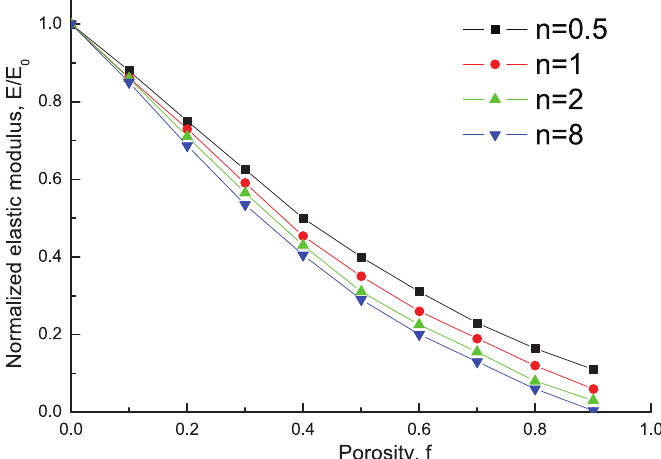
Figure 14. Normalized effective elastic moduli of porous tantalum involving differently-shaped